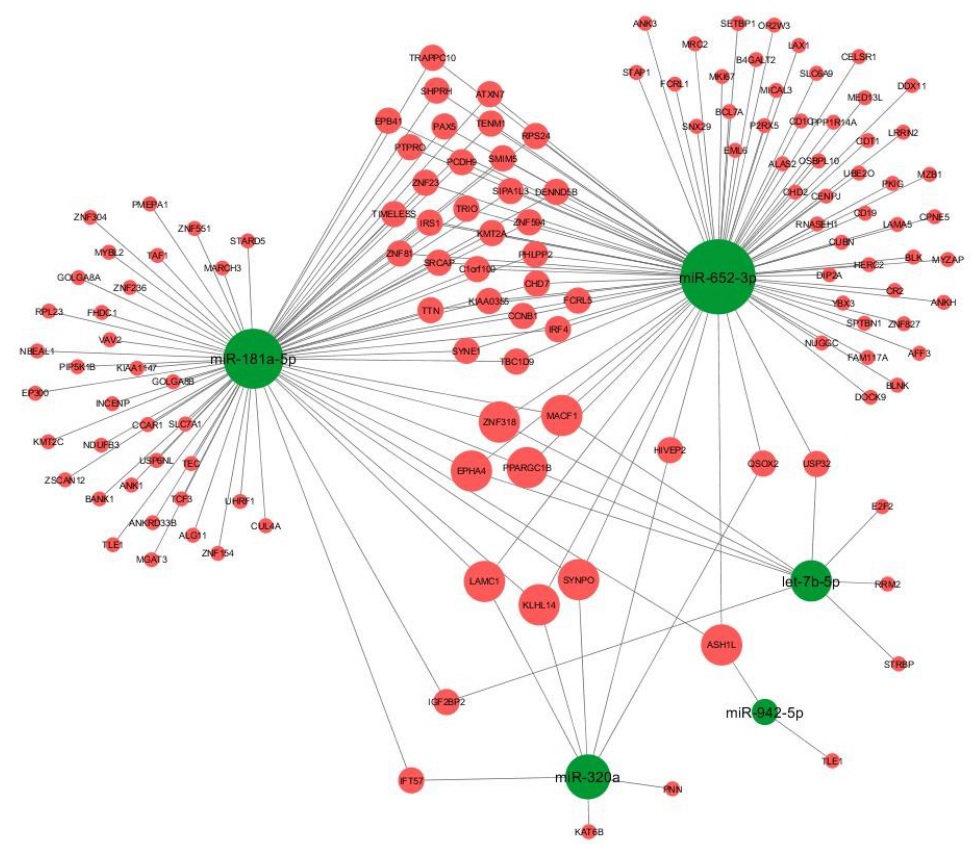
Figure 4. Graphical representation of miRNA-based targetome using Cytoscape v3.6.0. Only computationally predicted (three out of five algorithms) and / or validated miRNA-target interactions are shown. Green nodes represent miRNAs, red nodes represent target genes. The size of the nodes is proportional to the degree of the nodes (i.e., number of incoming and outcoming edges).